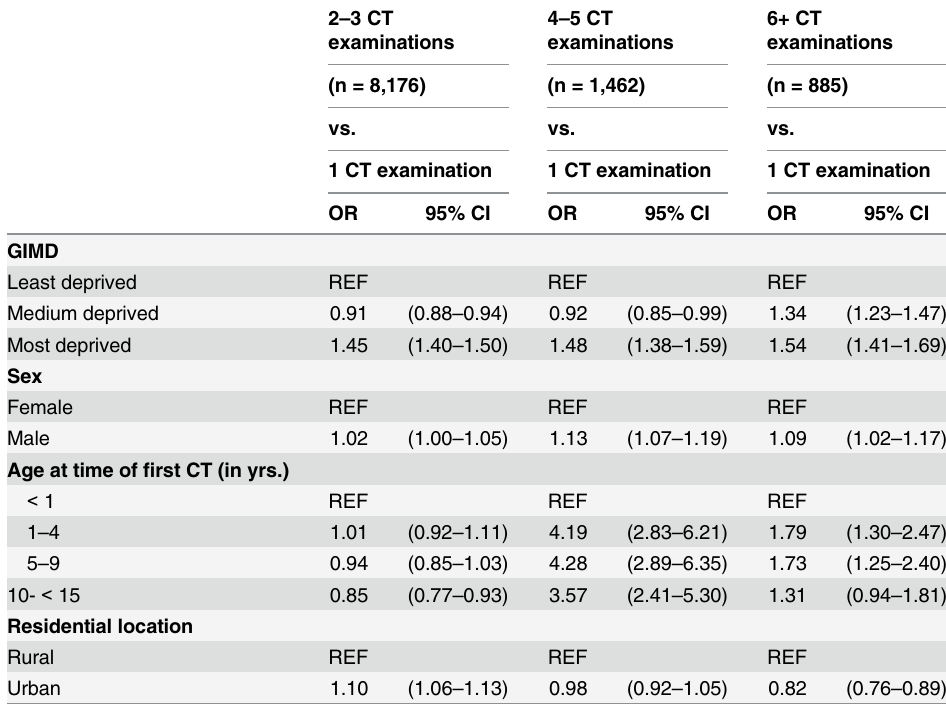
Table 3. Adjusted multinomial logistic regression results: Odds ratio (OR) and 95% confidence inter- vals (95% CI) of CT numbers for three frequency categories (with 1 CT examination event as reference category, n =